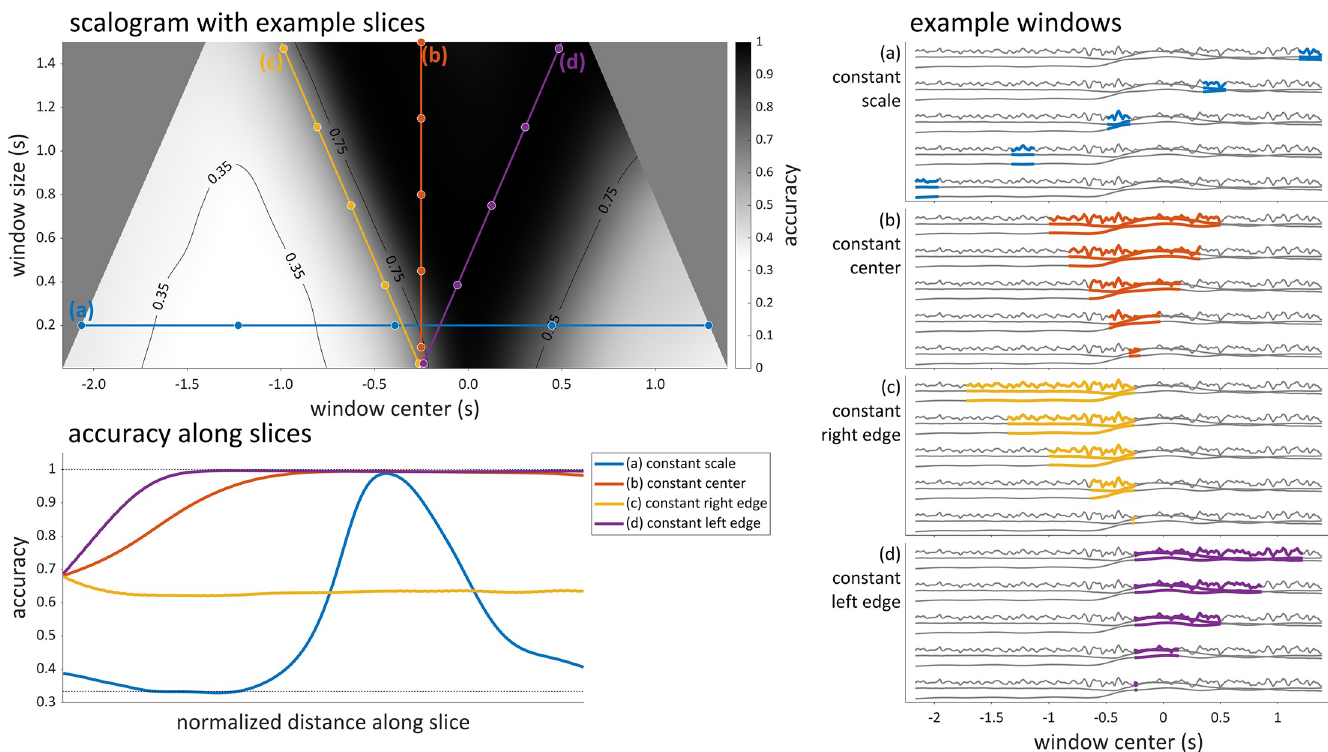
Fig 3. Example scalogram and interpretation. Top left: a smoothed, interpolated scalogram with four slices labelled (a)-(d), along with 35% and 75% accuracy contours. Bottom left: accuracies along each slice. Right panels (a)-(d): examples of signal windows for each of the five points in each slice. The shading of the scalogram represents the average classification accuracy on test data, for analyses conducted at each combination of window size (vertical dimension) and window cen- ter (horizontal dimension). In this particular example, we have used a grayscale colormap to represent accuracy, and chance performance is 1/3. The uniform gray triangular regions on the left and right of the scalogram represent analyses that are not conducted because they would require zero-padding of the input. The four lines labeled (a)-(d) in the scalogram repre- sent slices of the scalogram in which some property of the analysis window is constant. For each slice, five points have been marked in the scalogram and the analysis windows corre- sponding to each of those points are indicated by the colored portions of the signals in the pan- els on the right. Specifically, in the constant scale slice (a), which corresponds to a horizontal line in the scalogram, window scale is the same for all analyses; hence each of the five windows shown in panel (a) is the same size (here 0.200 s). Note that in each of the panels (a)-(d) which show example windows, the same set of three-dimensional input signals is repeated five times, and the colored portions indicate the extent of signal that would be used for the particular win- dow centers and scales indicated by the dots shown in the scalogram. The accuracy along slice (a) is shown in the lower left of Fig 3 (blue line). Notice that the accuracy along this slice is slightly above chance for analysis windows that occur early, falls to chance for windows that are centered a bit later, rises to near 100% accuracy around time 0.0, and then falls back down again. From this pattern we can infer that there is a lot of category-related information in the input around time 0.0, which is the alignment point in this example. We can also infer that there is some category-related information in the beginning of the signals.